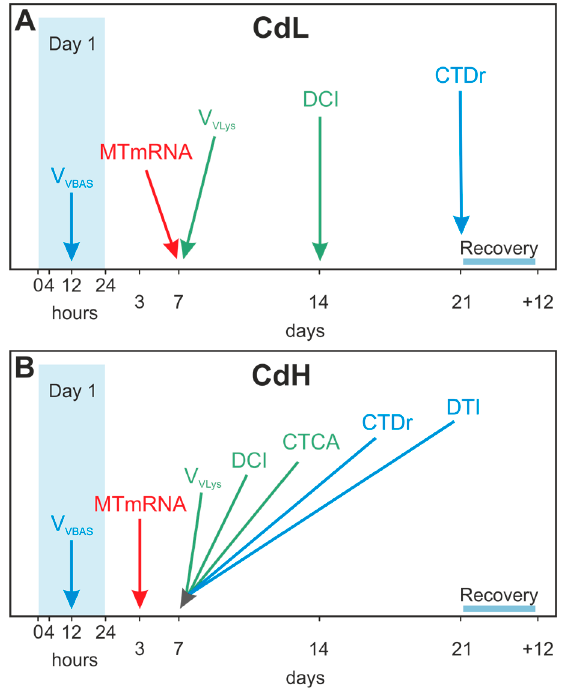
Figure 13. Time course of the onset of molecular (red), cellular (green) and tissue-specific alterations (blue) in Littorina littorea exposed to sub-lethal low (CdL) ( A ) and high (CdH) ( B ) Cd concentrations through 21 days of exposure, followed by a 12 days period of recovery. Abbreviations: MT mRNA: MT mRNA copy numbers, Vv LYS : Volume Density of lysosomes in digestive cells of midgut gland tubules, DCI: Digestive cell integrity of midgut gland tubules; CTCA: presence of connective tissue calcium cells in the midgut gland, V VBAS : Volume density of basophilic cells in the epithelium of midgut gland tubules, DTI: Digestive tract integrity. CTDr: Connective tissue to digestive tubule ratio.